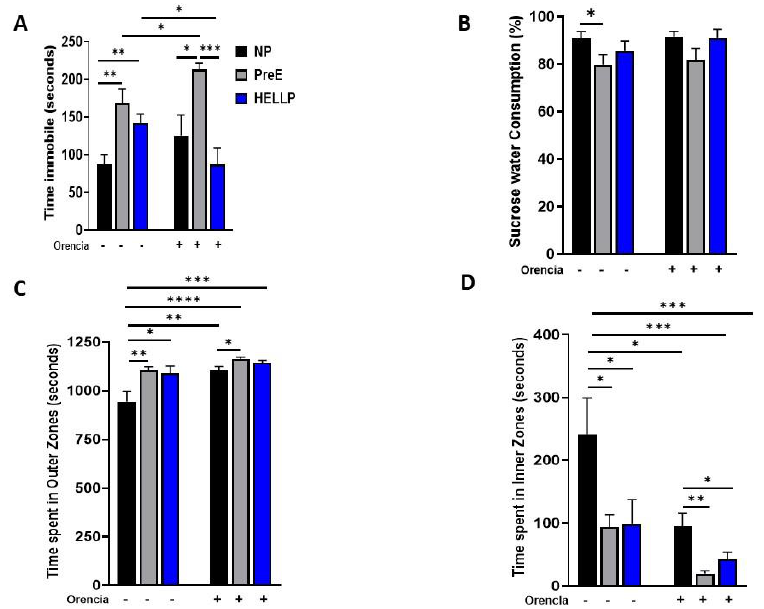
Figure 3. Dams with hypertensive disorders of pregnancy have more immobility and open-area anxiety. Depressive-like behavior, or anhedonia, was assessed in the forced swim test ( A ) and with sucrose preference ( B ). The time spent in the outer zones ( C ) and inner zones ( D ) of the open-field arena was used to assess open-area anxiety. Data were analyzed by two-way ANOVA followed by Tukey’s post hoc test and presented as mean ± SEM (n = 11–13/group). *–**** denotes p < 0.05– p < 0.00005 in comparison to the indicated group. Abbreviations: NP (normal pregnant); PreE (preeclampsia); HELLP (hemolysis elevated liver enzyme low platelet). Anhedonia was evaluated via sucrose preference over tap water. There was a significant group effect [F 2,53 = 3.6, p = 0.03] in sucrose preference where PreE rats drank significantly less sucrose relative to NP rats ( p = 0.04; Figure 3B). There were no significant effects among HELLP rats, regardless of Orencia treatment.